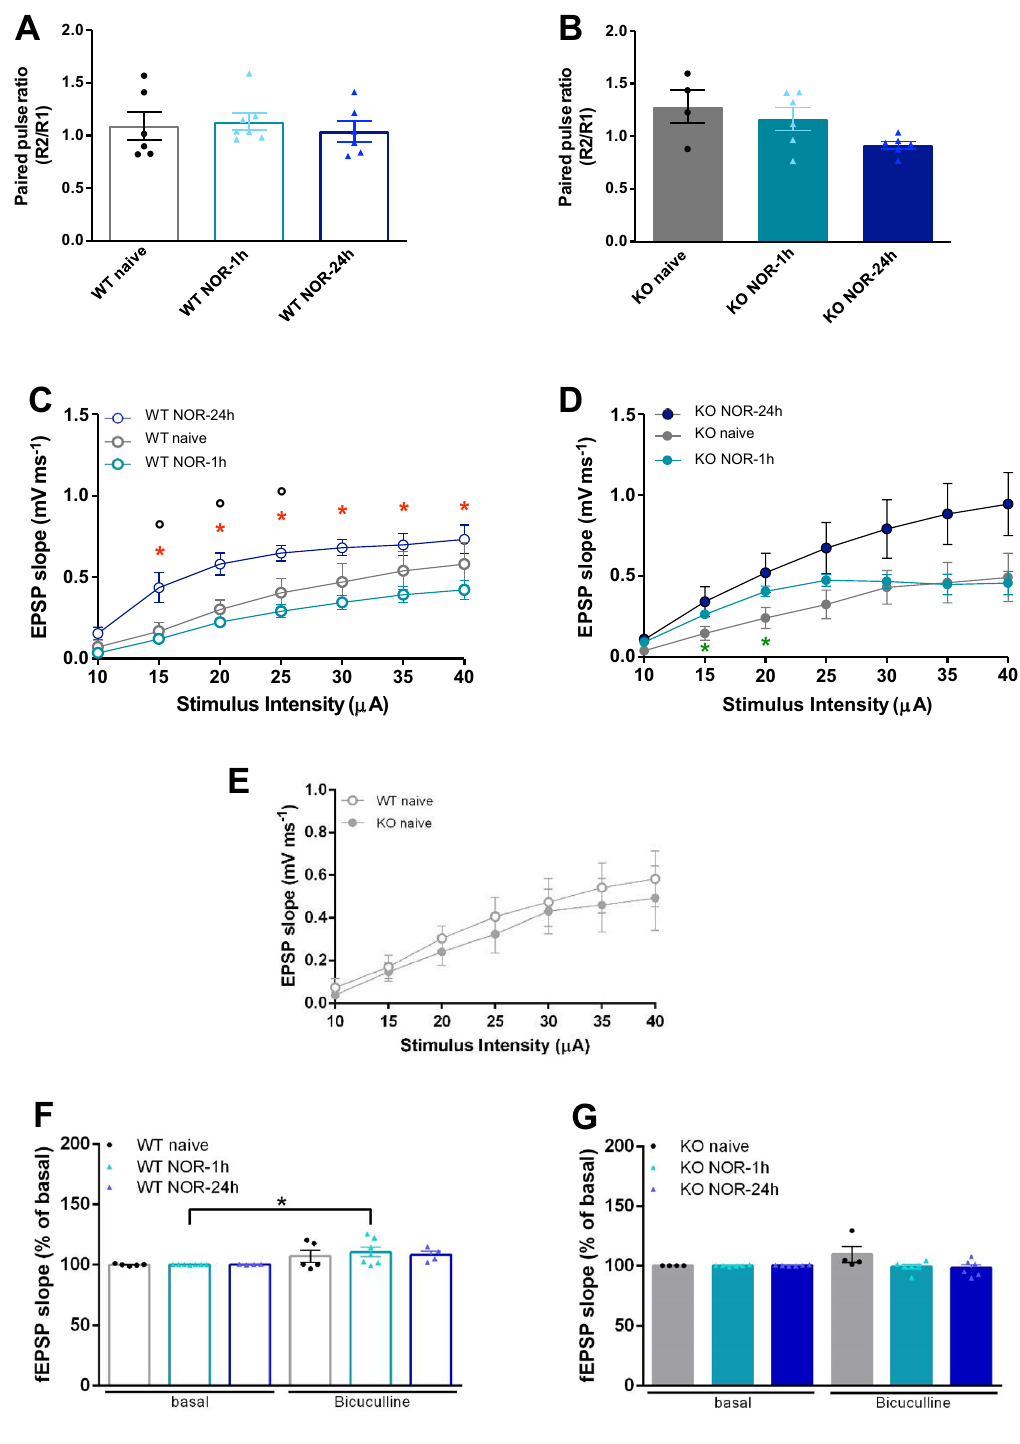
Figure 4. Normal PPR but higher fEPSP slopes in mice exposed to long-term NOR. ( A , B ) PPR measured in WT ( A ) and KO ( B ) mice are comparable regardless of the training condition (p > 0.1 for all comparisons; Mann–Whitney test). ( C , D ) I/O curves depict the ratio between fEPSP slope (mV ms −1 ) and the stimulation intensity (µA). Each point on the I/O curve was obtained by averaging responses over 2–5 min of recording and progressively increasing the stimulus strength. ( C ) WT mice curves are comparable in naive and NOR-1 h conditions but not in the NOR-24 h condition where the curve indicates a higher I/O ratio (°p ≤ 0.05 vs naive; *p < 0.05 vs NOR-1 h; Mann–Whitney test). ( D ) KO mice curves are also largely superimposable in naive and NOR-1 h conditions except for the 15 and 20 µA stimulation intensities which trigger higher responses in the latter group (*p < 0.05 vs naive; Mann–Whitney test). As in WT mice, the NOR-24 h curve of KO mice depicts a thoroughly higher I/O ratio compared to naive KO mice, and partially higher compared to KO NOR-1 h mice (at 30–40 µA stimulus intensities), but, in both cases, the differences were not statistically significant; ( E ) The I/O ratios in naive WT and KO mice are superimposable; ( F , G ) Application of bicuculline induces typical disinhibition of LPP synaptic activity in WT NOR-1 h mice (*p < 0.05, Wilcoxon test) whereas this effect is absent in WT NOR-24 h mice ( F ) and both NOR-1 h and NOR-24 h KO mice ( G ). WT naive: n = 5 slices from 3 mice; WT NOR-1 h: n = 7 slices from 3 mice; WT NOR-24 h: n = 4 slices from 3 mice; KO naive: n = 4 slices from 2 mice; KO NOR-1 h: n = 6 slices from 3 mice; KO NOR-24 h: n = 6 slices from 3